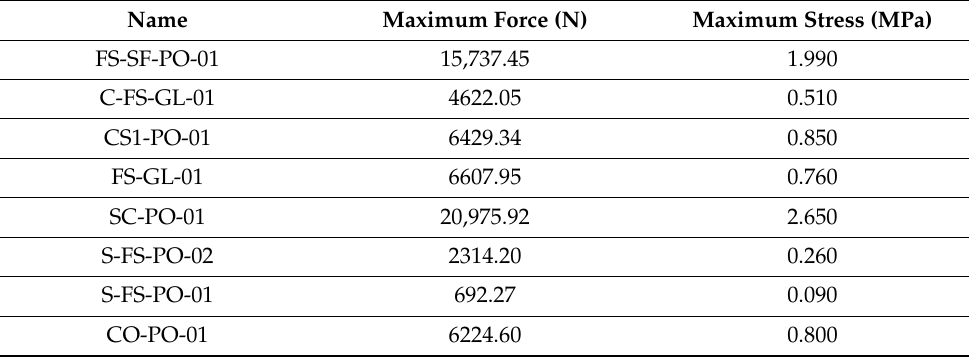
Table 3. Compression test of various